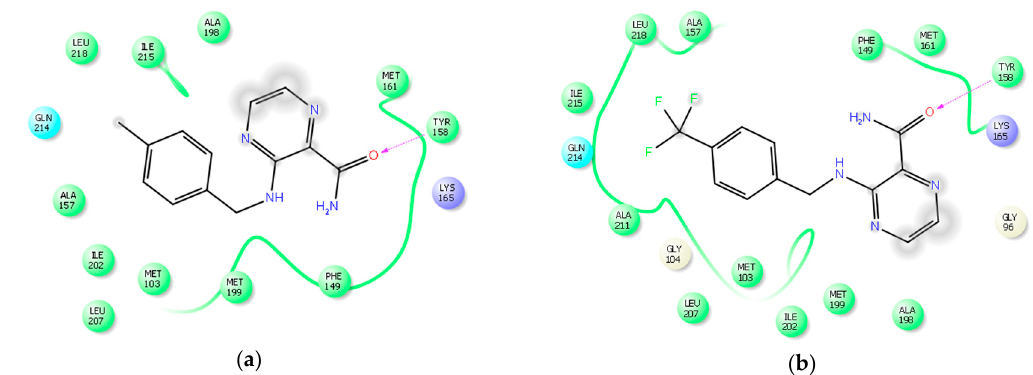
Figure 4. 2D visualization of ( a ) compound 8 and ( b ) compound 12 in active site of InhA showing interactions with the substrate binding loop.